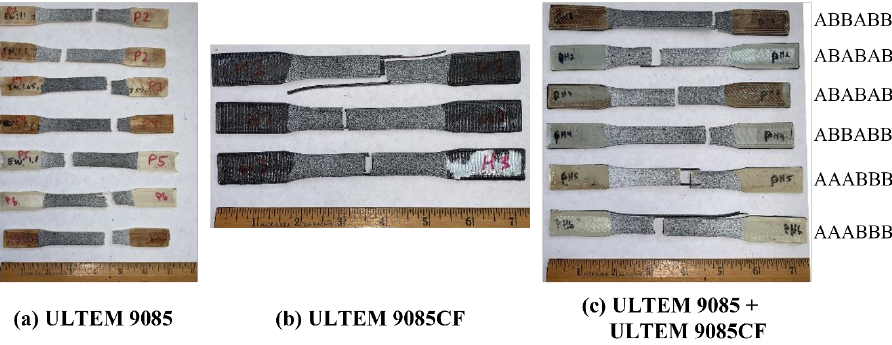
Figure 7. ( a ) ULTEM 9085, ( b ) ULTEM 9085CF, and ( c ) ULTEM 9085 + ULTEM 9085CF specimens after undergoing fracture during tensile testing.